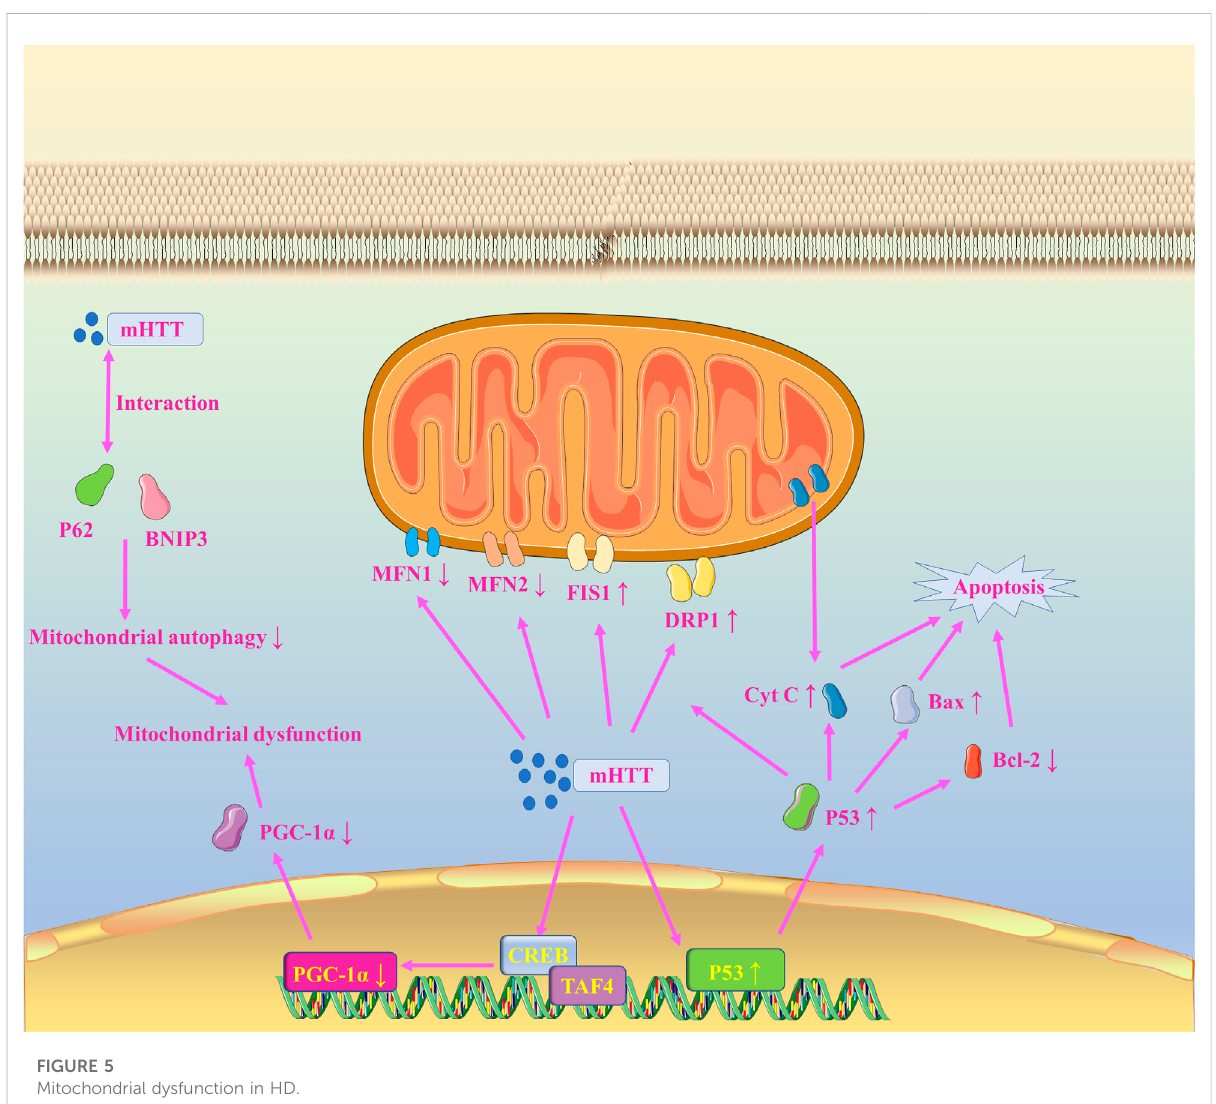
FIGURE 5 Mitochondrial dysfunction in